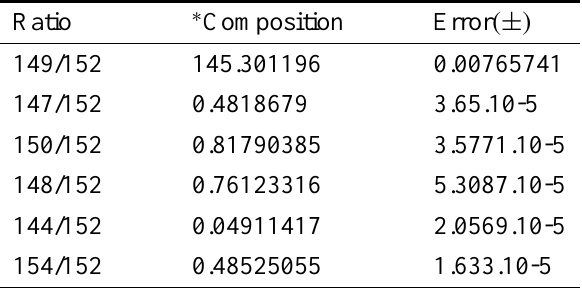
Isotopic Ratio for natural Nd in mixed Spike, cali- brated using Blankwash-tech and BCR-1 rock stan-